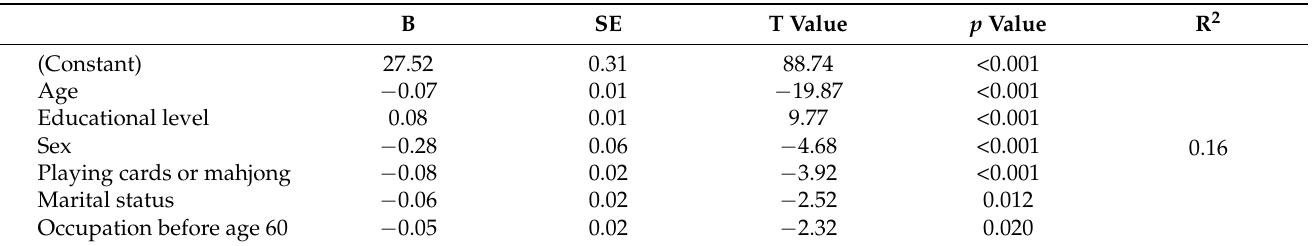
Table 4. Stepwise regression analysis between total MMSE scores and playing cards or mahjong and other covariates ( n =